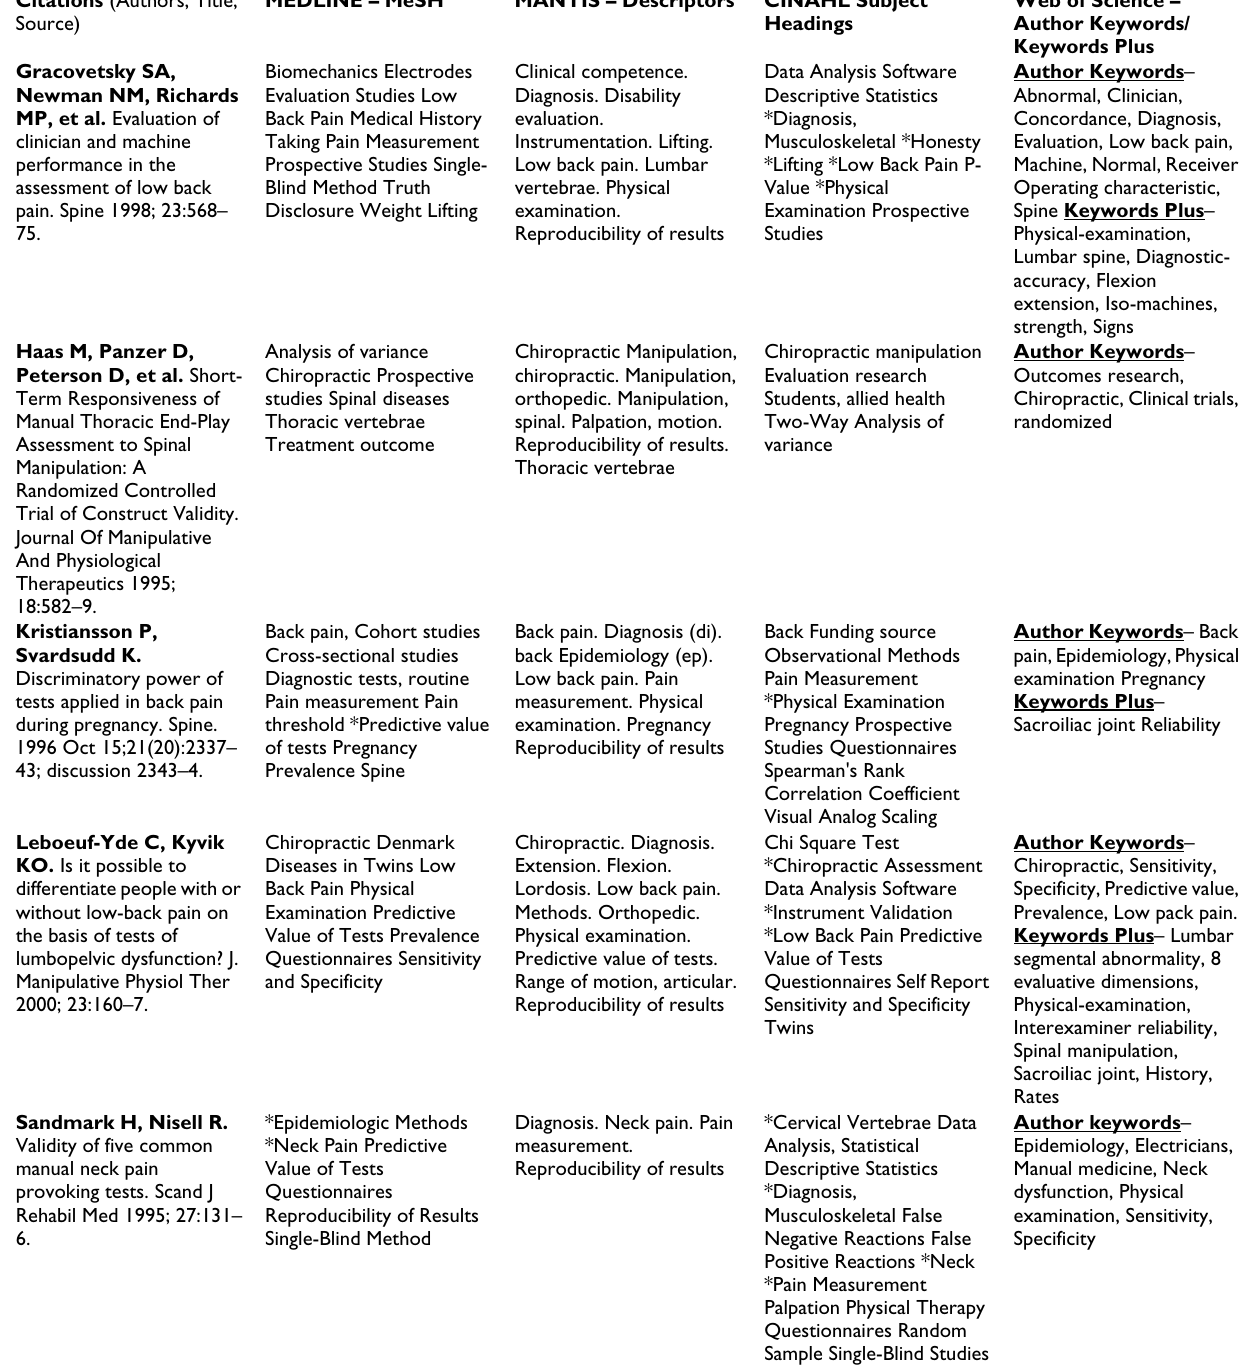
Table 6: Comparison of five studies indexed in all four databases (subheadings, gender, age group, human/animal, and publication type were